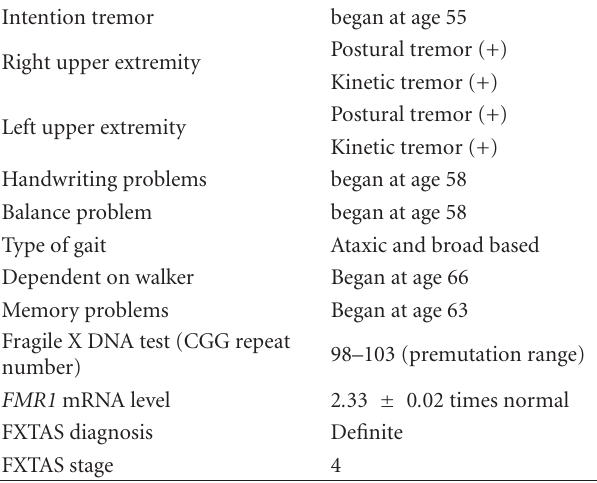
Table 1: FXTAS clinical, neuroimaging, and molecular results of the